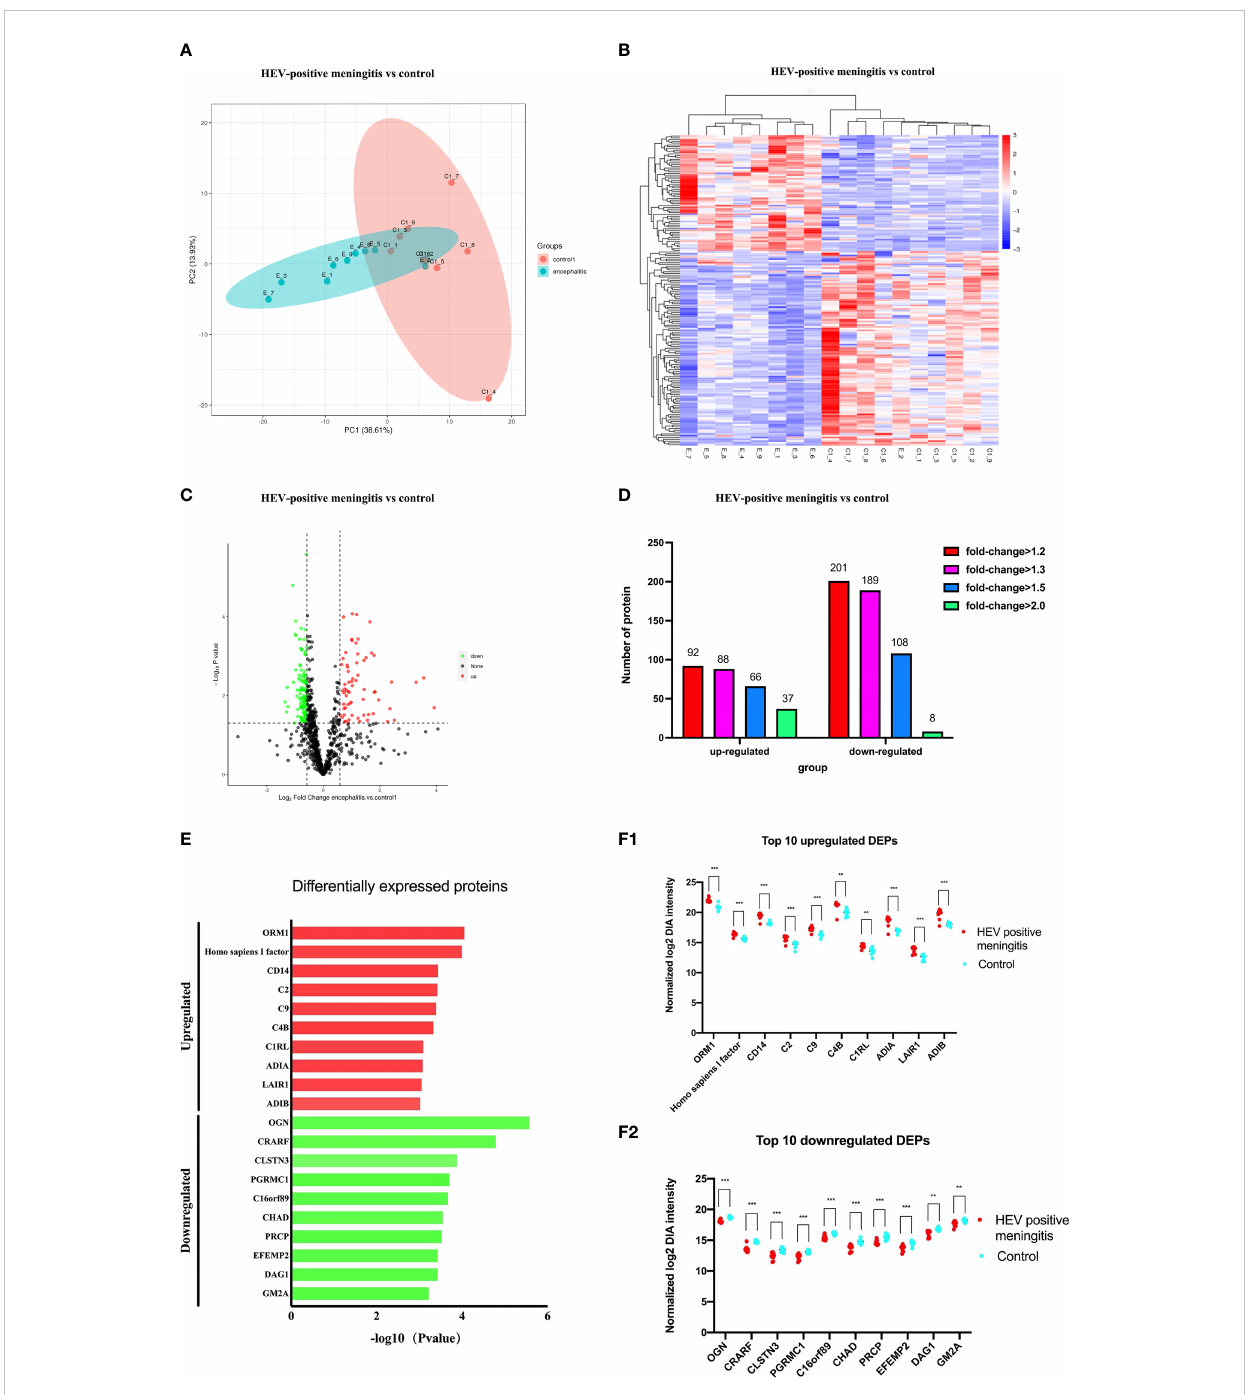
FIGURE 2 Comparison of protein expression pro fi les between patients with encephalitis and normal controls. (A) PCA of whole proteins from proteomics data. (B) Expression heatmaps of differentially expressed proteins. (C) Volcano plot of differentially expressed proteins between two groups: ∣ log2FC ∣ > 2, FDR < 0.01. (D) The up- and downregulated fold changes (log2) of proteins are colored according to each panel key. (E) Names of the top 10 up- (red) or downregulated (green) proteins between patients with HEV-positive meningitis and normal controls are listed in a bar chart. (F) Comparison of top 10 up- (B1) or downregulated (B2) protein abundance is shown by dot plots between patients with EV-positive encephalitis (red) and normal controls (blue). Relative expression levels (2 − DD Ct ) of these DEPs are shown according to the log scale. Corresponding protein names are listed at the bottom of the chart. * p <0.05, ** p <0.01, *** p